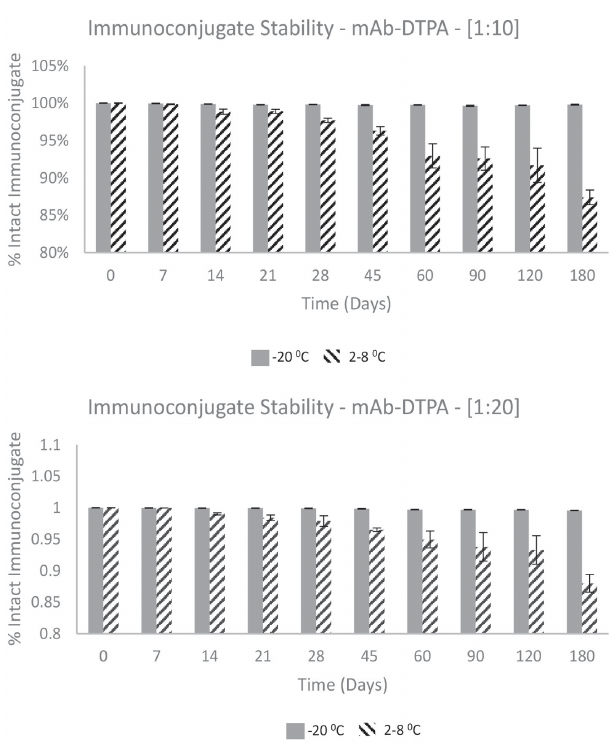
FIGURE 4 - HPLC stability study of immunoconjugate at different DTPA:mAb molar ratios and time after conjugation